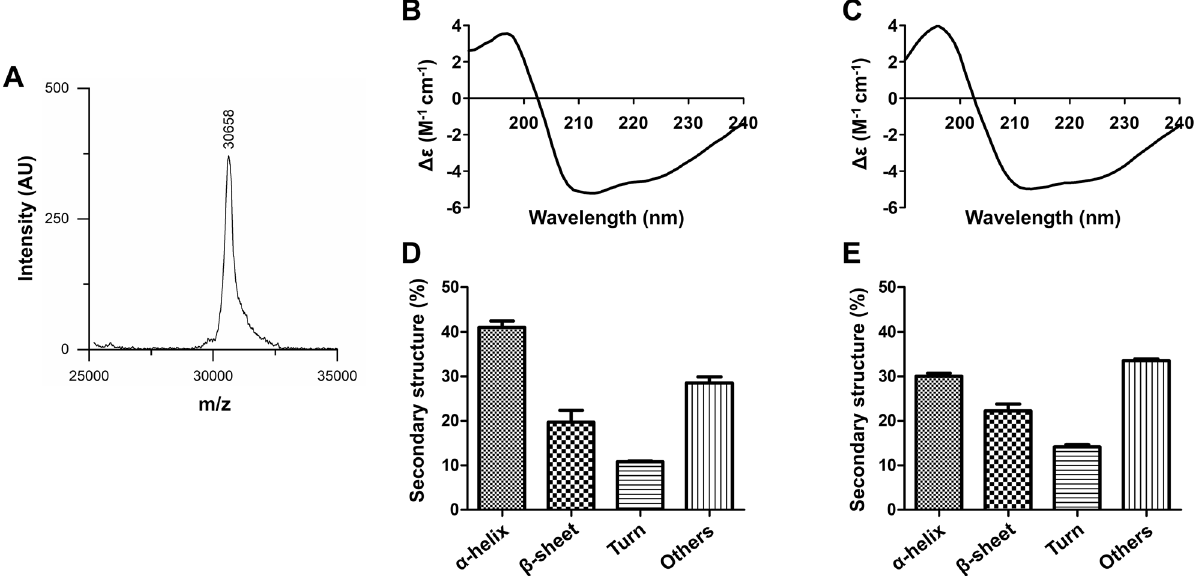
Figure 5. MALDI-TOF and Circular dichroism spectroscopy analysis of the purified rhHAND2 fusion protein. ( A ) The MALDI-TOF–MS analysis of the purified HAND2 protein. The purified rhHAND2 fusion protein was analyzed using MALDI-TOF, and the result is depicted using a graph with mass per charge (m/z) ratio on the X-axis and intensity (AU) on the Y-axis. ( B – E ) The secondary structure content of this purified rhHAND2 fusion protein was determined using far-UV CD spectroscopy. The obtained far-UV CD spectra were then evaluated using in silico BeStSel online tool. ( B , C ) The CD spectrum of the purified rhHAND2 fusion proteins induced at 37 and 18 °C, respectively, were plotted with Delta Epsilon (M −1 cm −1 ; Y-axis) against wavelength (nM; X-axis). ( D , E ) The bar graphs represent the quantified secondary structure of the purified rhHTN- HAND2 proteins induced at 37 and 18 °C,